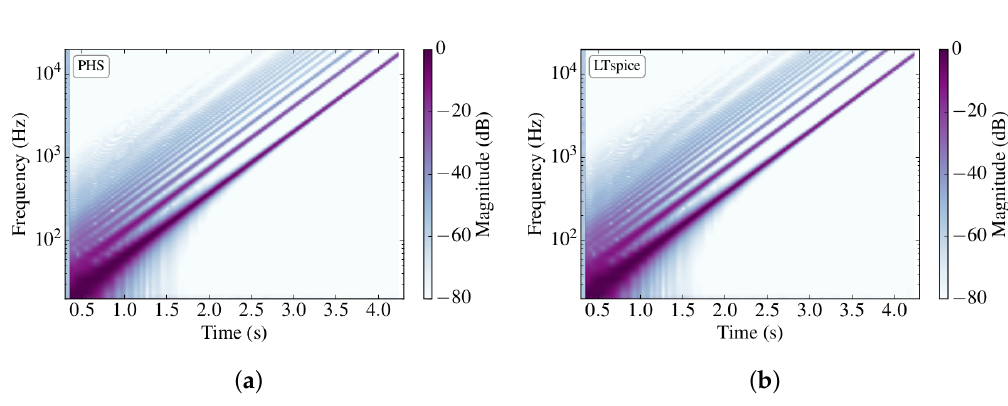
Figure 7. Results for the common-emitter BJT amplifier with feedback (Figure 6a). The input voltage signal is a 4 s exponential chirp on the audio range (20 Hz–20 kHz) with amplitude 0.05 V (logarithmic frequency scale). Simulation starts at 0.3 s (after the switching transient). ( a ) Spectrogram of output v OUT obtained with the proposed method; ( b ) Spectrogram of output v OUT obtained with